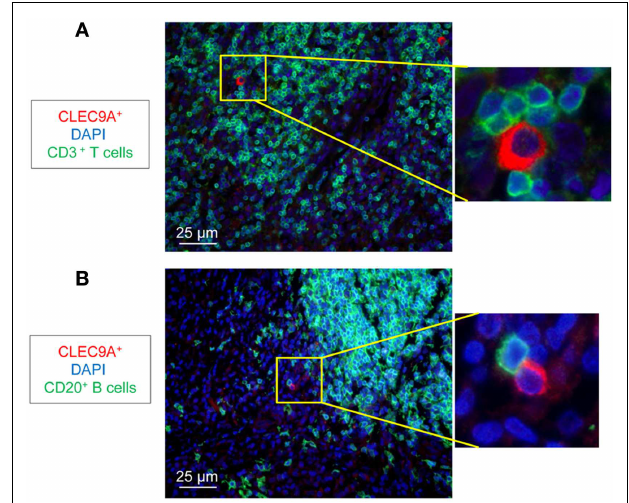
FIGURE 2 | Identification of CD141 hi DCs in LNs ofTB patients . Immunostaining of CD141 hi DCs (CLEC9A) with (A) T cells (CD3 + , green) and (B) B cells (CD20 + , green). DAPI (blue) indicates cell nuclei. Magnification 40 × . One representative experiment out of threeTB cases